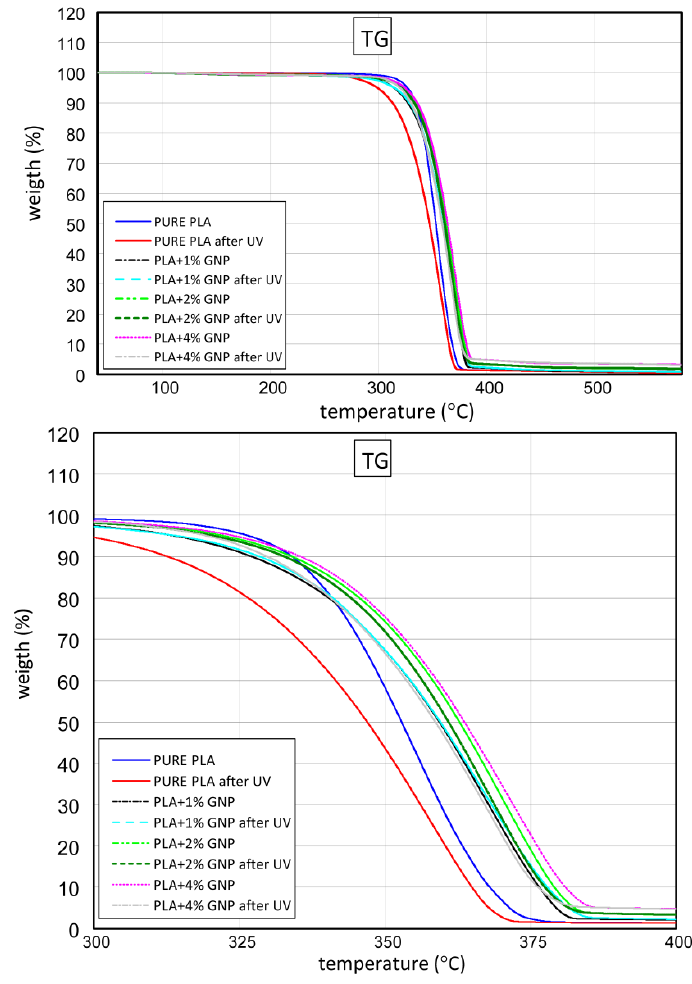
Figure 6. The curves of TG test in the fully realised range ( a ) and in range of 300–400 °C ( b ). Table 2. Weight loss for PLA samples and PLA/graphene composites.